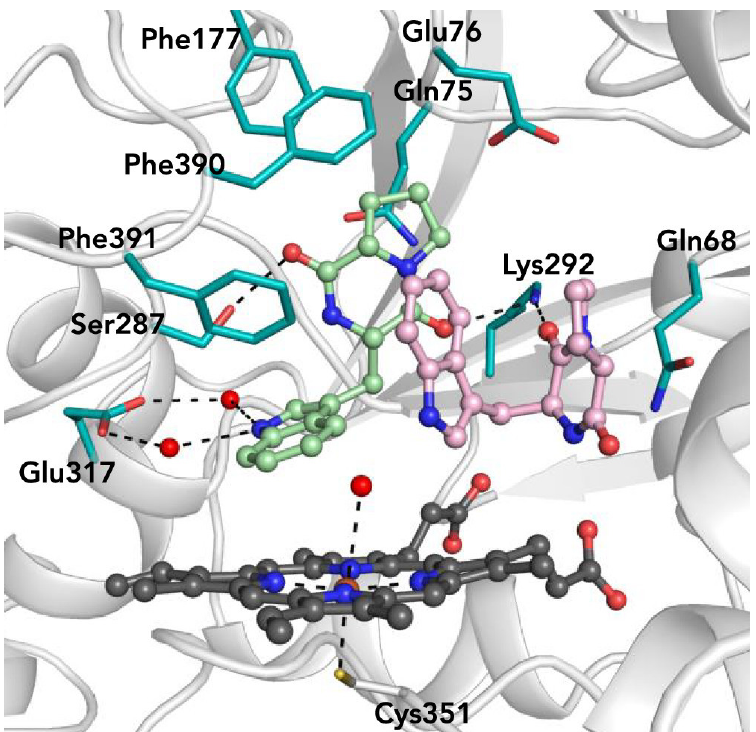
Figure 2. Active site of cytochrome P450 NzeB showing the concave substrate (pink) bound in the “cyclization site”, and the extended substrate (green) bound in the “dimerization site”. Reproduced with permission from [96], copyright © 2020, American Chemical Society.